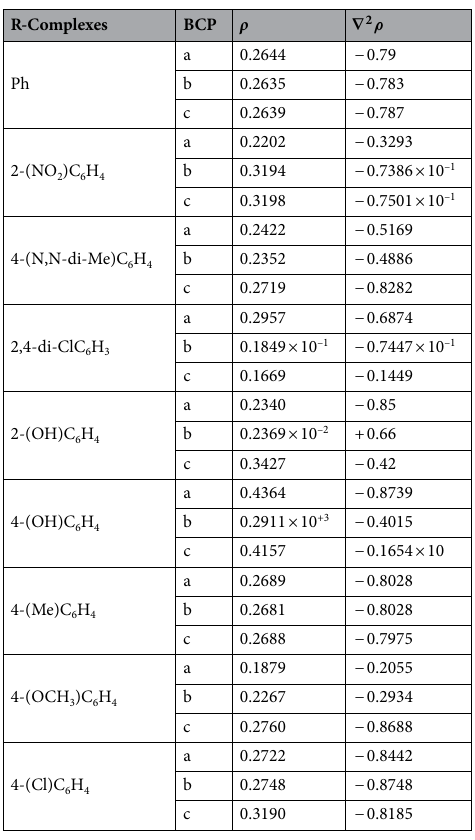
Table 4. Topological parameters of pyrazoloquinolines